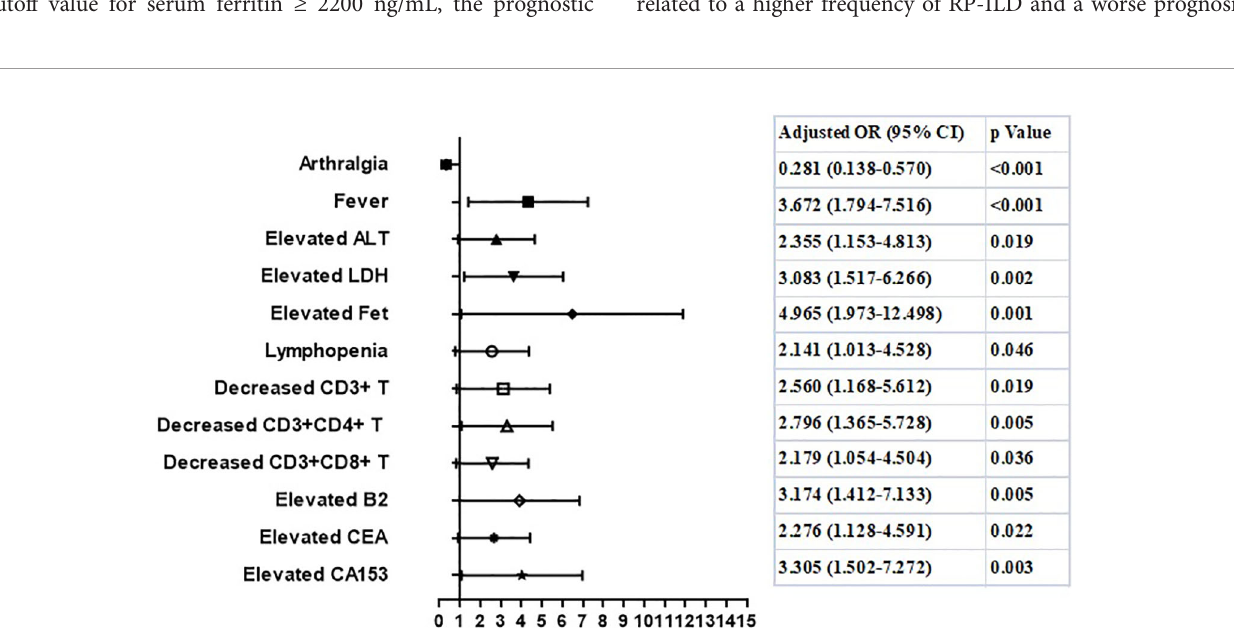
FIGURE 1 | Risk factors of RP-ILD in patients with anti-MDA5 antibody.